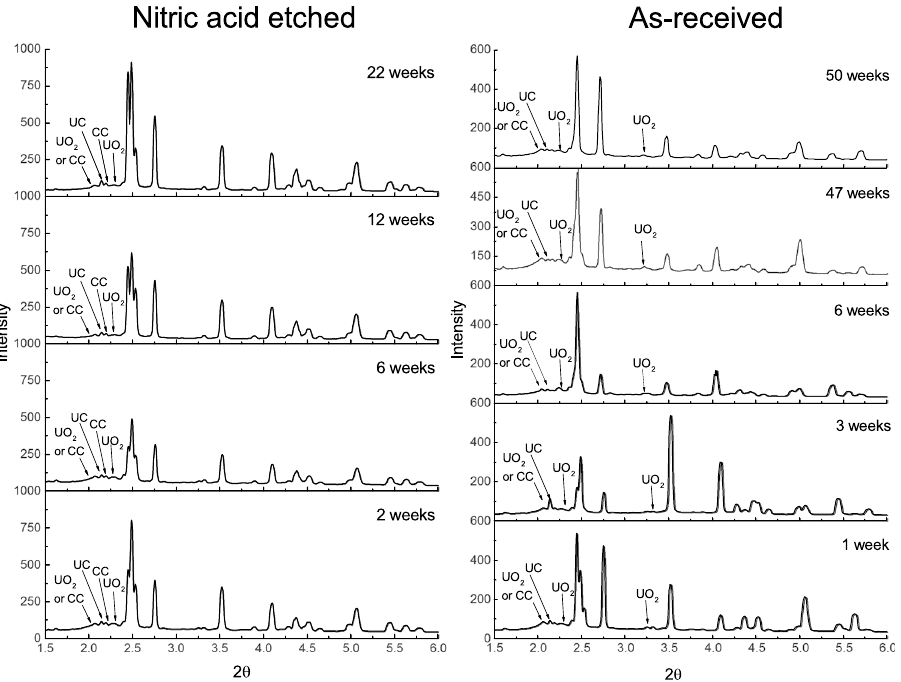
Figure 1. XRPD exhibiting the evolution of nitric acid etched and as-received, grout encapsulated uranium when exposed to de-ionised water vapour over time. CC = Calcium carbonate (CaCO 3 ). All unlabelled peaks are attributed to uranium